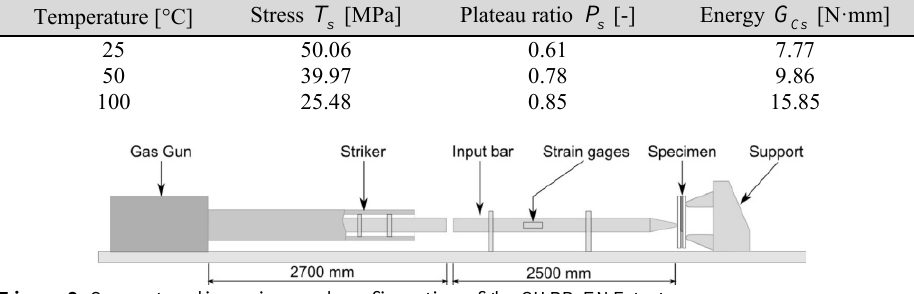
Figure 3. Geometry, dimensions and configuration of the SHPB ENF tests.